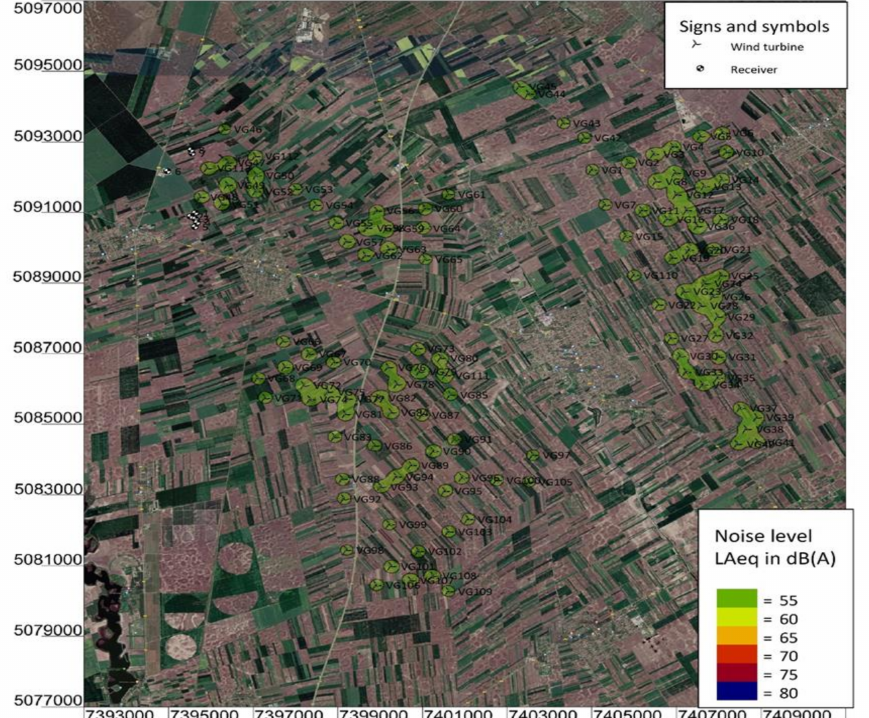
Figure 2. Results of modeling the spatial dispersion of noise for the day—evening period (coordinates are given in the Gauss-Kruger system).